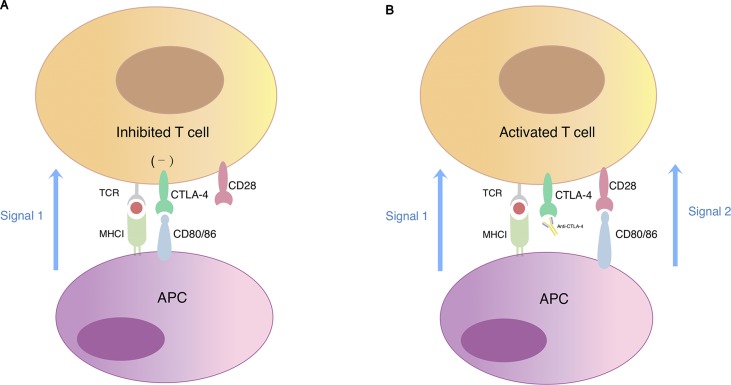
T cell activation regulated by CTLA-4 and CD28. (A) Simultaneous recognition of a specific major histocompatibility complex (MHC)–peptide complex by the T cell receptor (TCR) and of CD80/CD86 by the co-stimulatory receptor CD28 results in T cell activation. Cytotoxic T-lymphocyte-associated protein 4 (CTLA-4) is a CD28 homologue expressed on the surface of T lymphocytes with higher affinity for CD80/CD86. When CTLA-4 competitively binds to CD80/CD86, signal 2 required for T cell activation reduces, which eventually leads to T cell anergy. (B) The blockade of CTLA-4 signaling restores signal 2 in response to binding of CD28 with CD80/CD86 thus promoting T cell activation and proliferation.